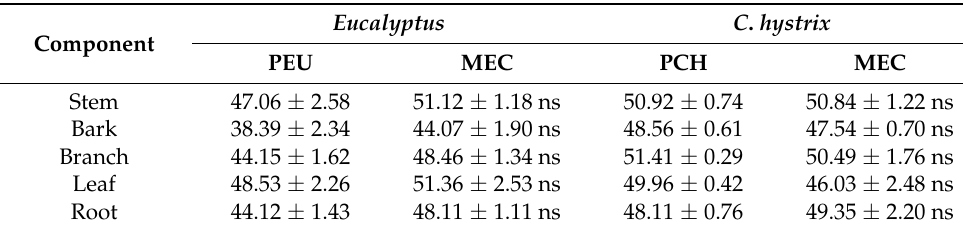
Table 5. Carbon content (%) in different components of Eucalyptus and Castanopsis hystrix trees in different plantation